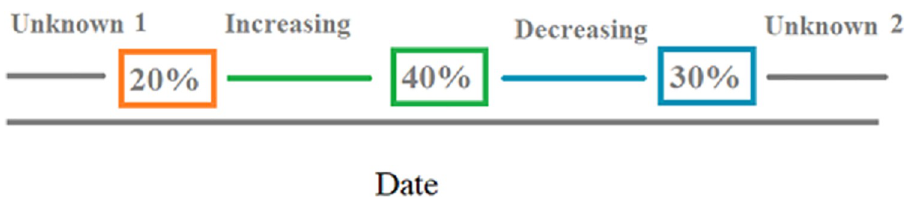
Fig 5. Example of categorisation of scoring periods as either increasing or decreasing tail injury. The percentages 20, 40 and 30 are included for illustration purposes to show the weighted total tail injury severity, and how changes in this metric would lead to a period being classified as increasing or decreasing. E.g. from 20% to 40% is an increase, while 40% to 30% is a decrease.